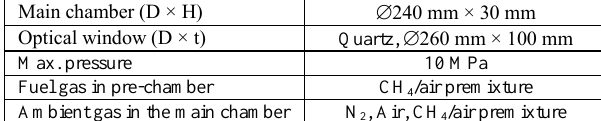
Fig. 1. Schematic of the constant volume combustion chamber (CVCC) Table 1. Main specifications of the CVCC